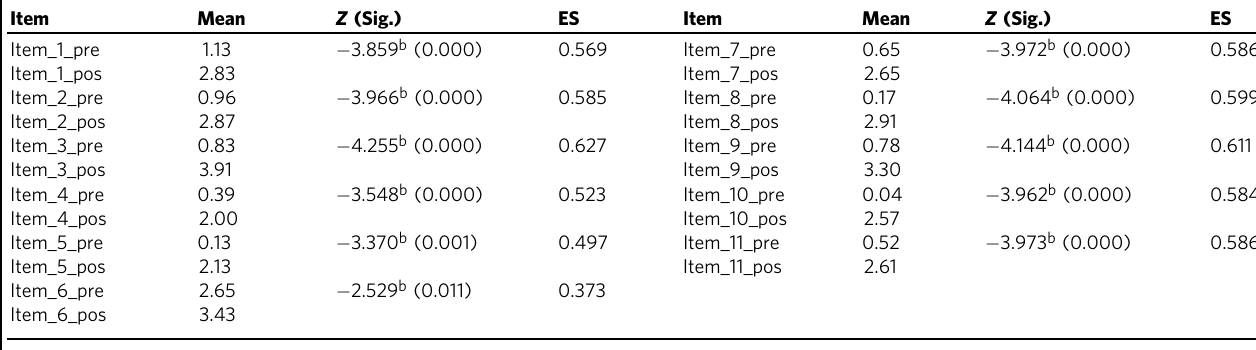
Table 4 Wilcoxon a W test of the posttest/pretest of the experimental group with the corresponding effect size. Item Mean Z (Sig.) ES Item Mean Z